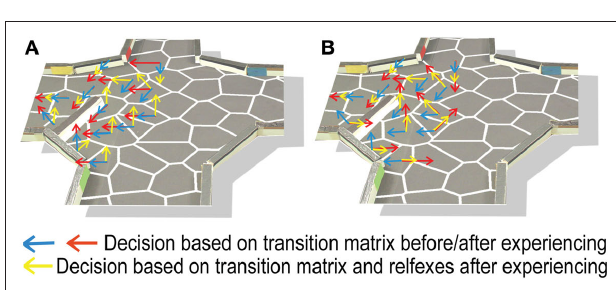
Figure  | The best decision in order to move to the target side. The different colored arrows correspond to the different conditions. Before the robot experiences the changed environment we executed the decision- making process based only on the transition matrix without the reflex factors (Blue arrow). After the adaptation process (online learning: 45 runs/batch learning: 2500 decisions see Figure  ) the decision process was calculated also without reflex factors based on the transition matrix (red arrow). The yellow arrows correspond to the condition of the integrated changes of the environment combined with the transition matrix and the reflexes. (A) represents the online learning while (B) batch Thus experience with the added obstacle was not fully integrated into the transition probabilities. In contrast, the action selection process based on both the transition matrix and the reflexes (yellow arrows) did show integration of the new environmental features.